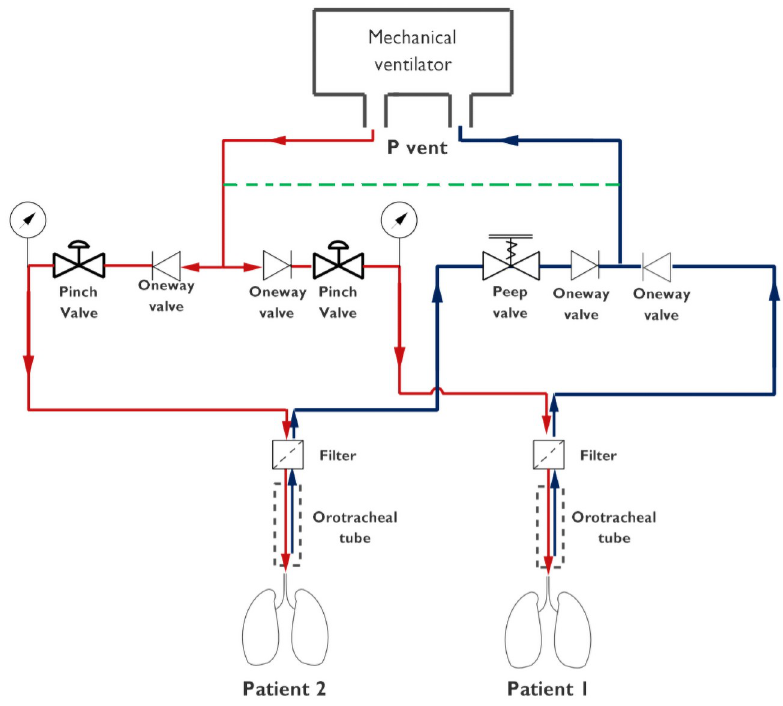
Fig 1. Basic single-line scheme of the two-compartment model. Inspiration and expiration circuits are coloured in red and black respectively. A dashed green line represents a short-circuit tubing of small diameter.